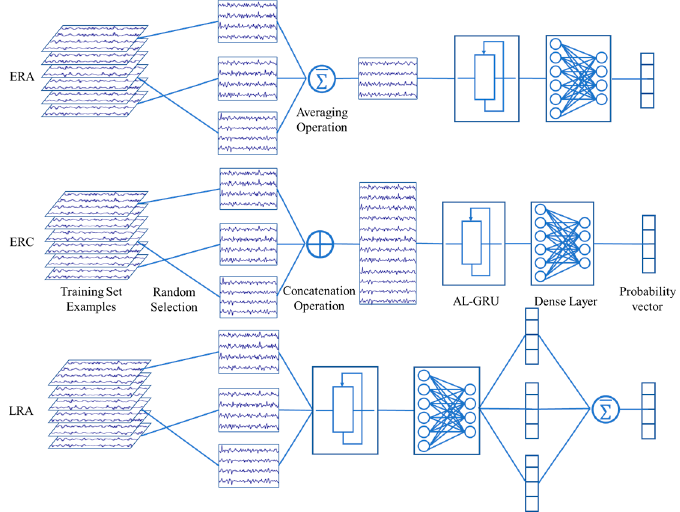
Figure 4. The processes of combination strategies. ERA—early randomly averaging. ERC—early random concatenation. LRA—late randomly averaging.